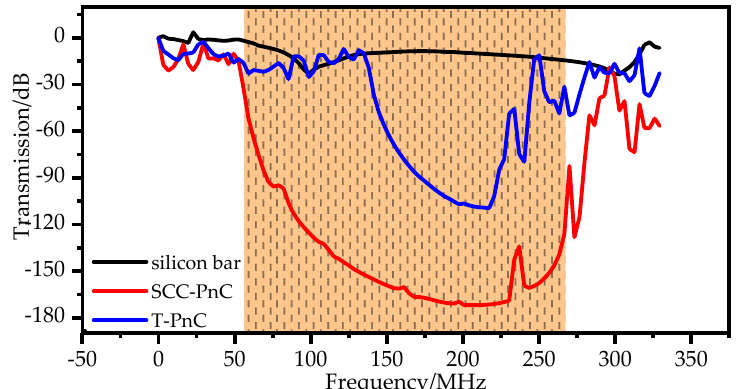
Figure 6. Transmission spectra of two kinds of phononic crystals and reference group along the Γ − X direction.